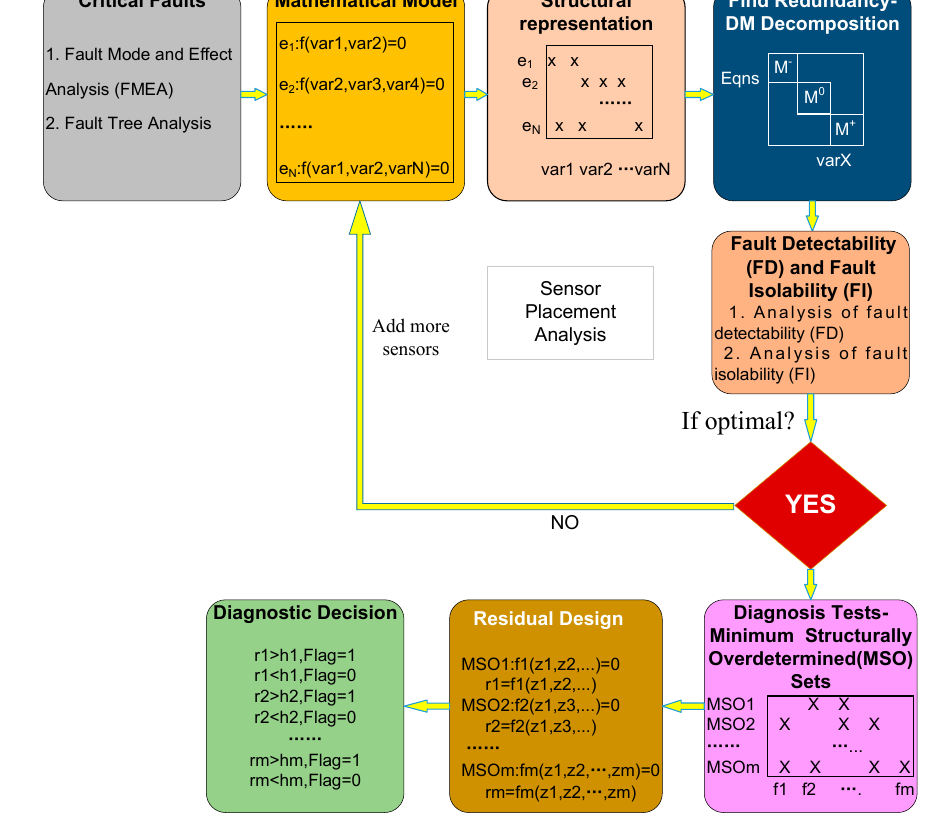
Figure 2. Main steps of structural analysis.